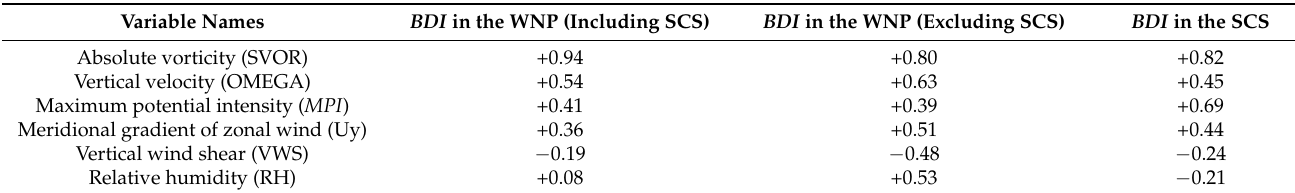
Table 2. BDI values of environmental factors in measuring the difference between November 2019 and the climatological mean in different sea